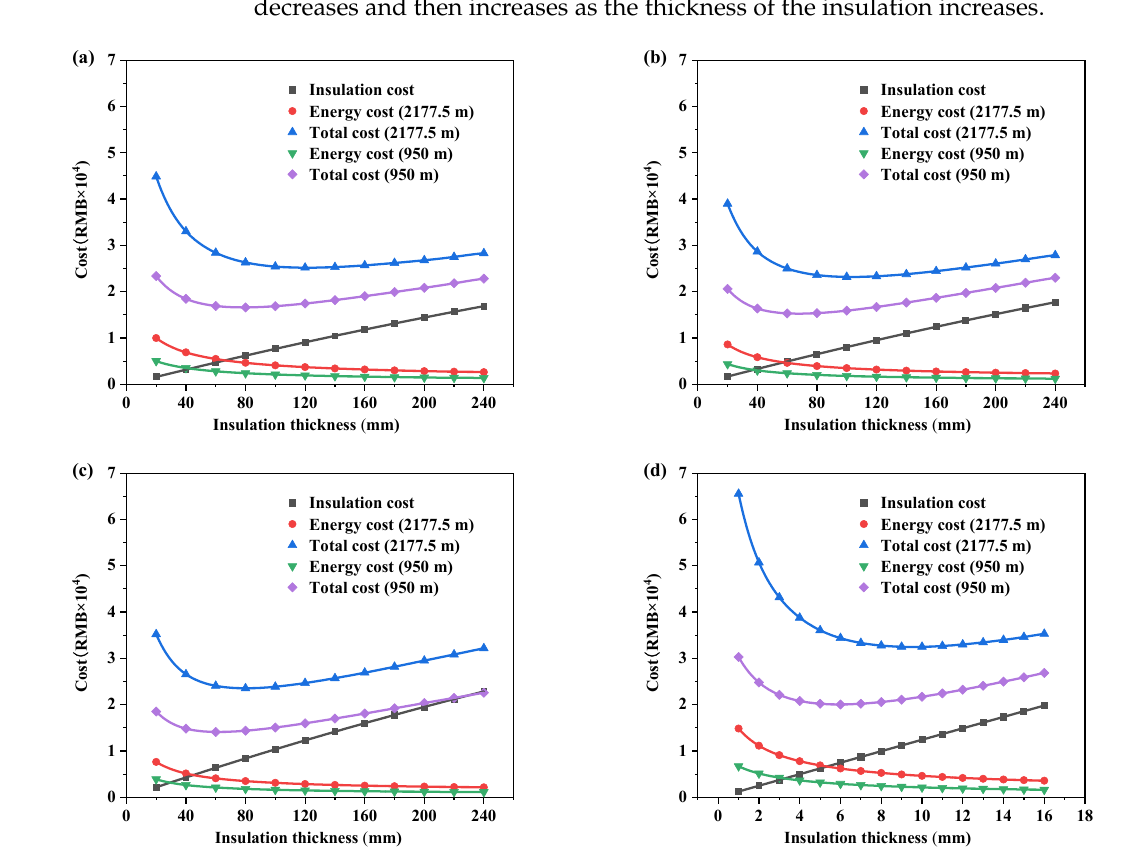
Figure 7. Carbon emissions of the original envelope and the optimized envelope, in terms of differ- ent service lives ( a ) 2177.5 m; ( b ) 950 m. Note: The U -values of the optimized envelope meet the NZEB standard.